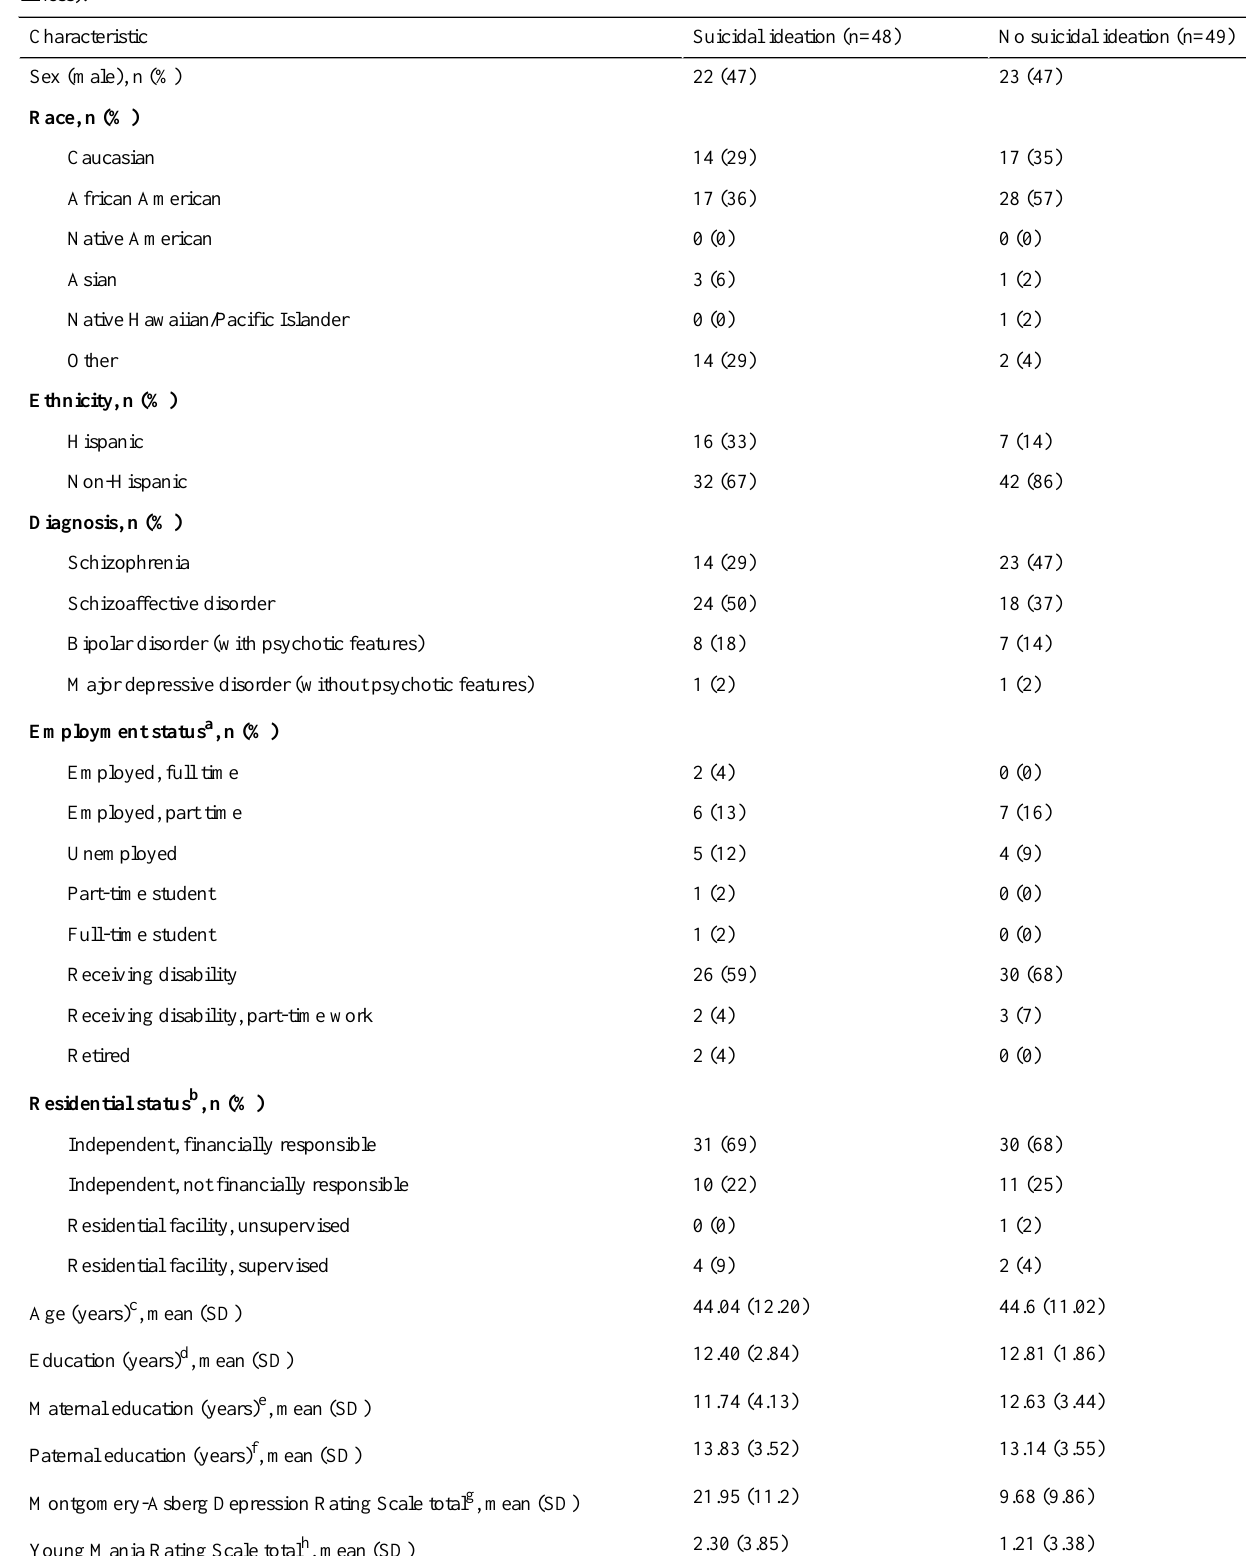
Table 2. Participant demographic and clinical characteristics from parent study 2 (note: this study includes only individuals with a diagnoses of mental